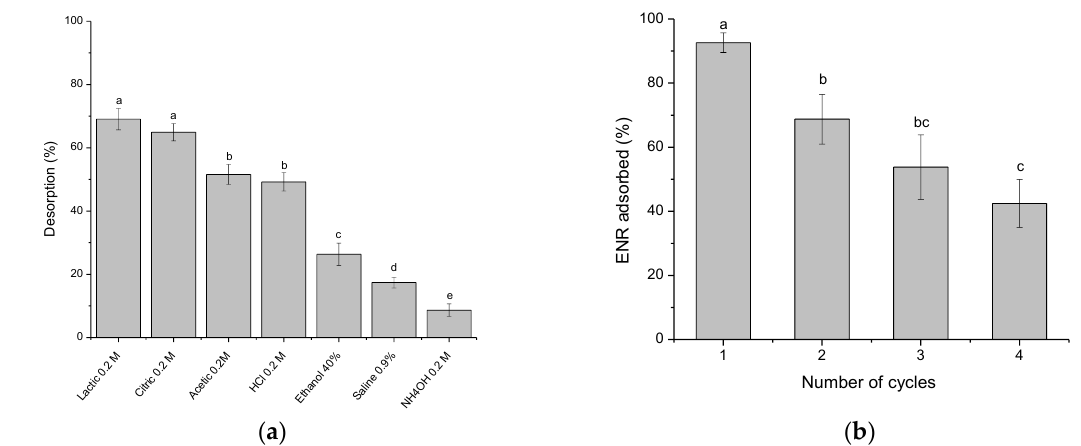
Figure 11. ( a ) Enrofloxacin desorption using different eluents, and ( b ) the reusability study of the P. koidzumii sorbent (adsorbent dose 8 g/L; 100 mg ENR/L; desorption time 40 min; and temperature 298 K). Those means that do not share a common superscript differ significantly (Tukey p < 0.05).